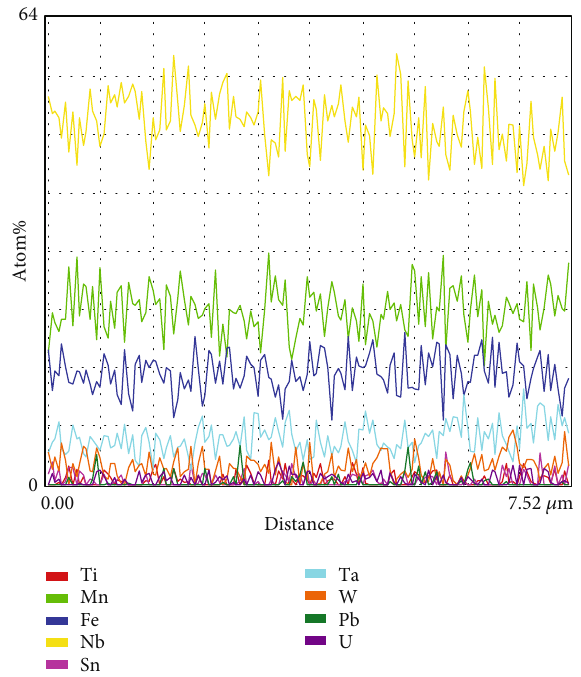
Figure 4: SEM line analysis of columbite-tantalite mineral grain indicating the homogeneously distributed elements.